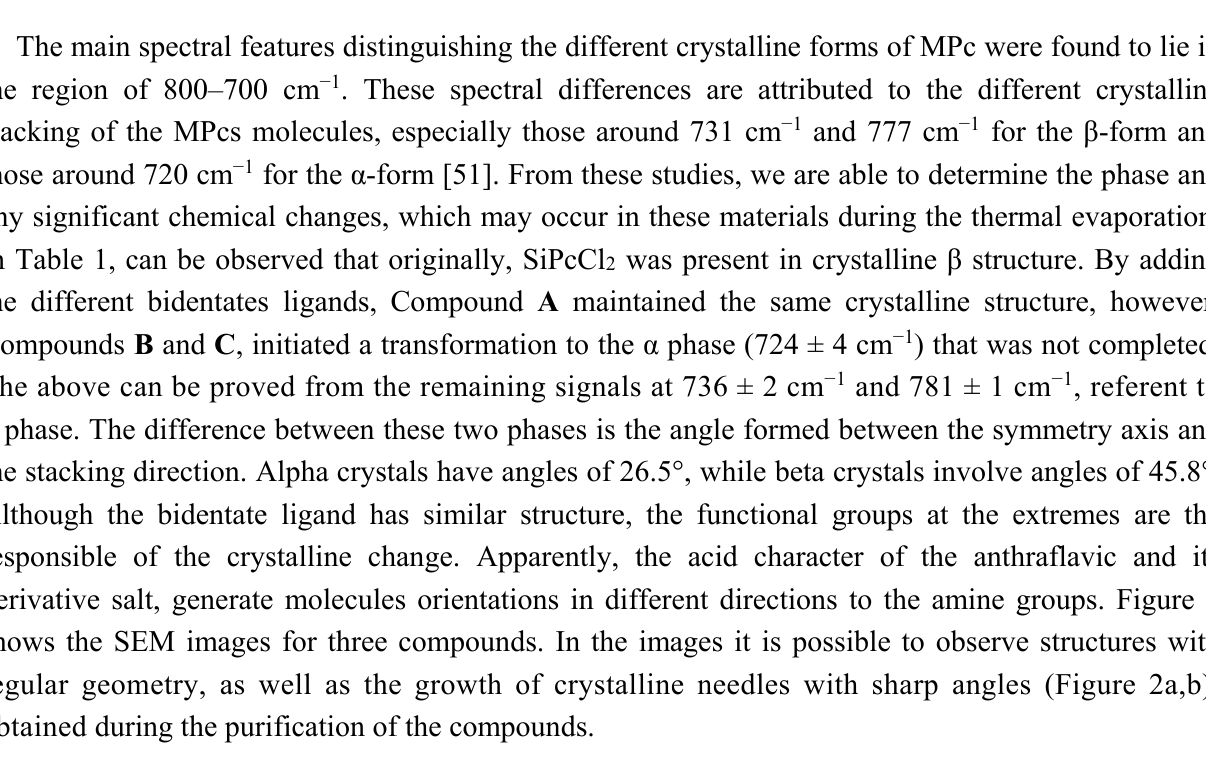
Figure 2. Scanning electron microscopy (SEM) micrographs of: ( a ) Compound A ; ( b ) Compound B ; and ( c ) Compound C films at